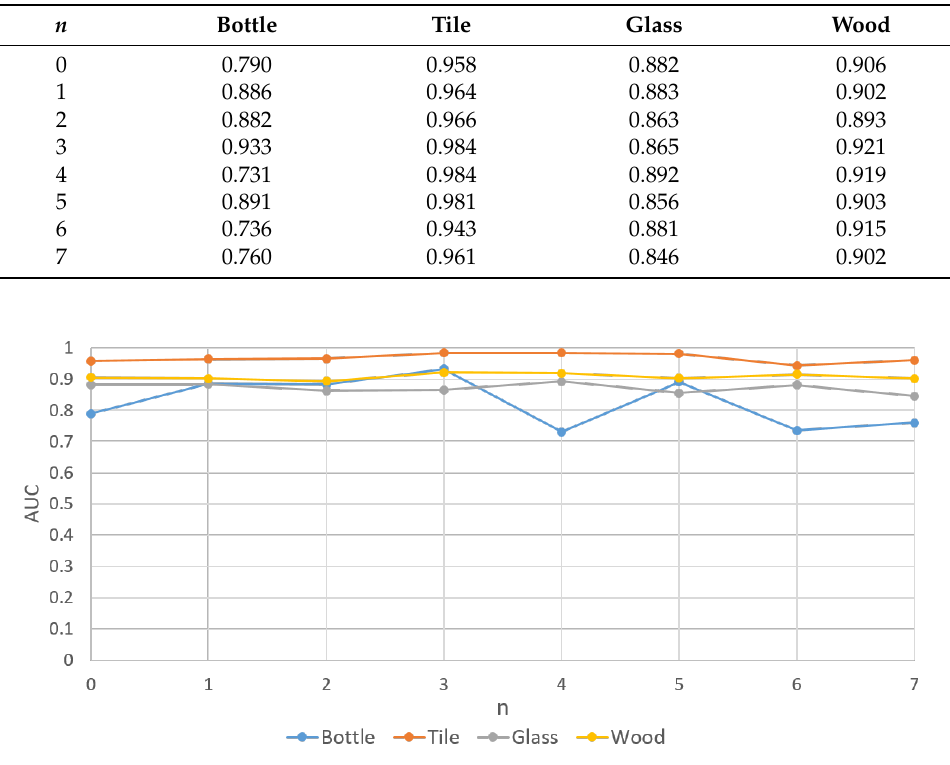
Figure 10. AUCs of training the proposed method (DAGAN) with few data ( 2 n ,0 ≥ n ≥ 7 )